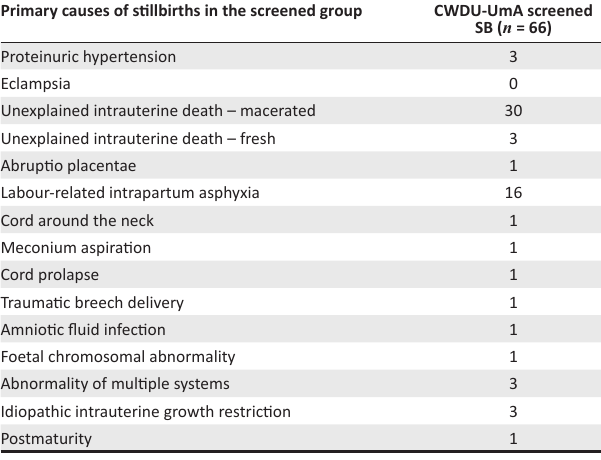
TABLE 2a: Primary causes of stillbirths and neonatal deaths for the continuous wave Doppler ultrasound of the umbilical artery screened study group. Primary causes of stillbirths in the screened group